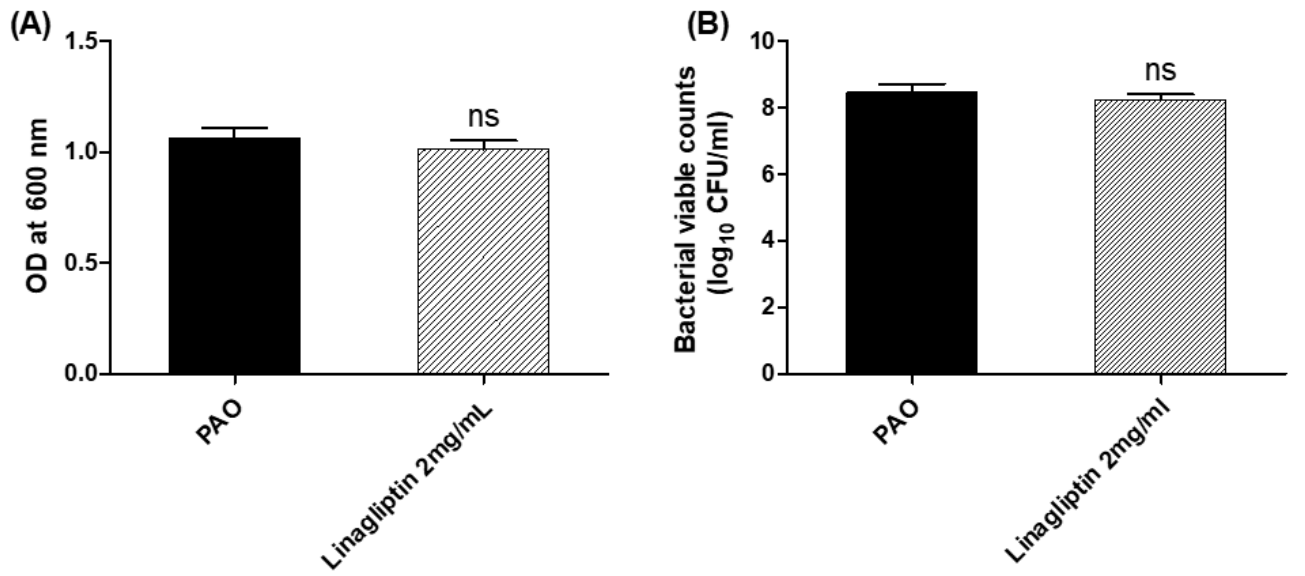
Figure 1. Linagliptin does not affect P. aeruginosa growth. To avoid any effect of linagliptin on bacterial growth prior to evaluating its anti-virulence activity; P. aeruginosa was grown in the presence or absence of linagliptin at sub-MIC. There was no significant effect of linagliptin at sub-MIC on ( A ) optical densities, and ( B ) bacterial counts of P. aeruginosa cultures. ns: non-significant ( p > 0.05).